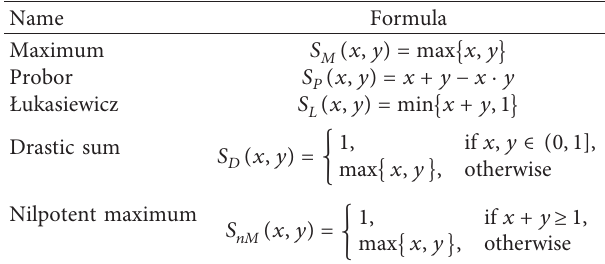
Table 2: Basic t -conorms.